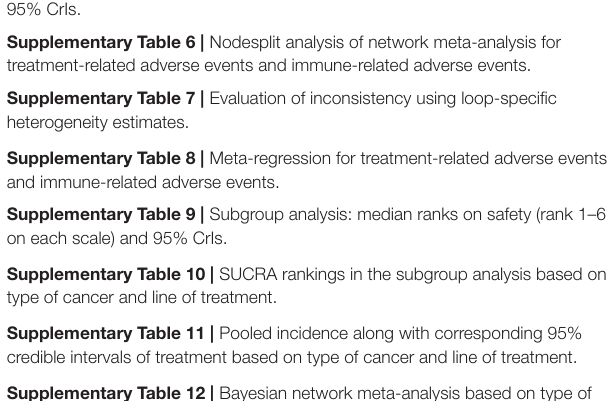
Supplementary Table 2 | Risk of bias summary. Supplementary Table 3 | Results of traditional pairwise meta-analyses for different outcomes. Supplementary Table 4 | Evaluation of the quality of evidence using GRADE framework for outcomes.